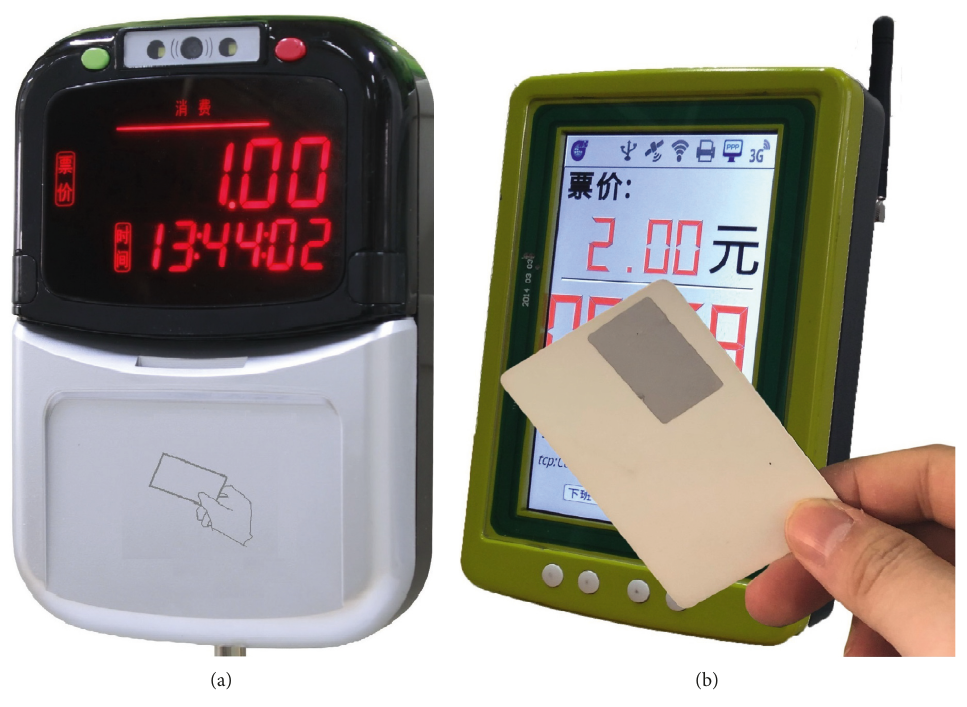
Figure 1: Two types of POS. (a) POS with up-down layout. (b) POS with antenna on LCD.